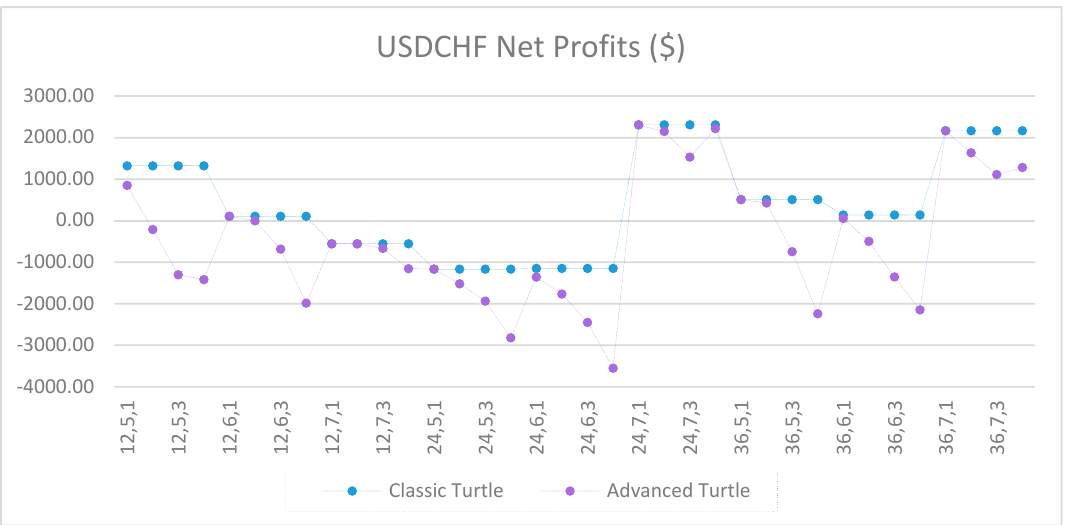
Figure A55. Net profits of USDCHF between the classic and the advanced Turtle systems for every combination of N, X, Y for the slow parameters (80, 160), where X ≥ 5.